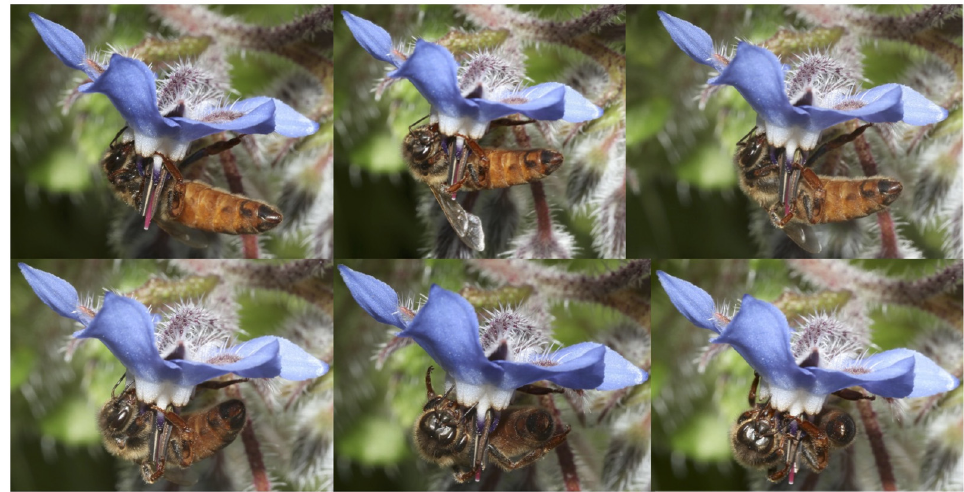
Figure 1. A honey bee queen ( Apis mellifera L.) while feeding on a borage flower ( Borago officinalis L.) (Uri, Sardinia, Italy; photo: Pietro Niolu).